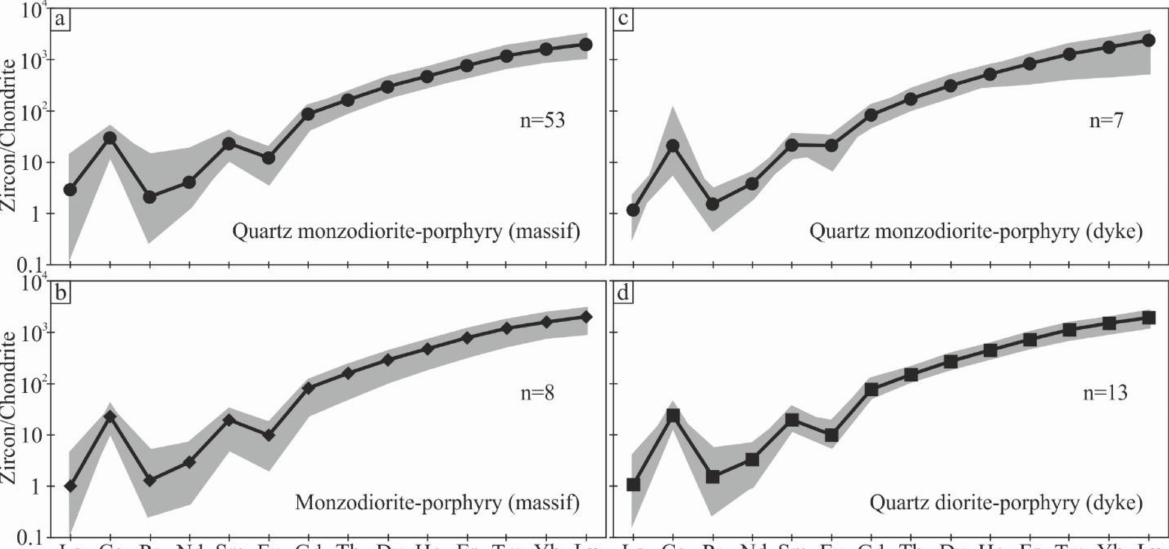
Figure 7. Chondrite-normalized REE patterns for zircons from the magmatic ( a , b ) massif and ( c , d ) dyke rocks of the Kultuma deposit. Solid lines correspond to the average values for each rock